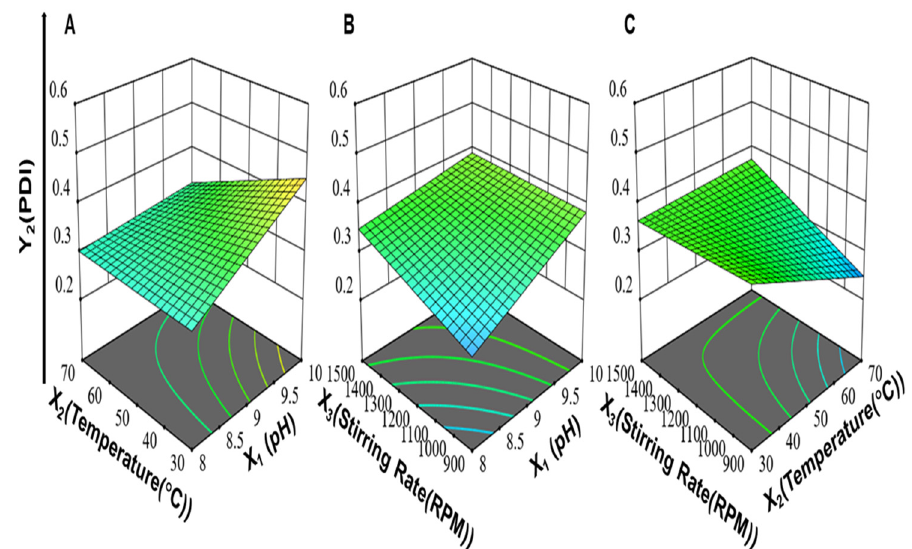
Figure 2. The 3-D response surface plots for ( A ) the interaction between pH and reaction tempera- ture (X 1 X 2 ), ( B ) the interaction between pH and stirring rate (X 1 X 3 ), and ( C ) the interaction between reaction temperature and stirring rate (X 2 X 3 ) on PDI (Y 2 ) of ZnO NPs while keeping the third varia- ble at an average value between its high and low levels.